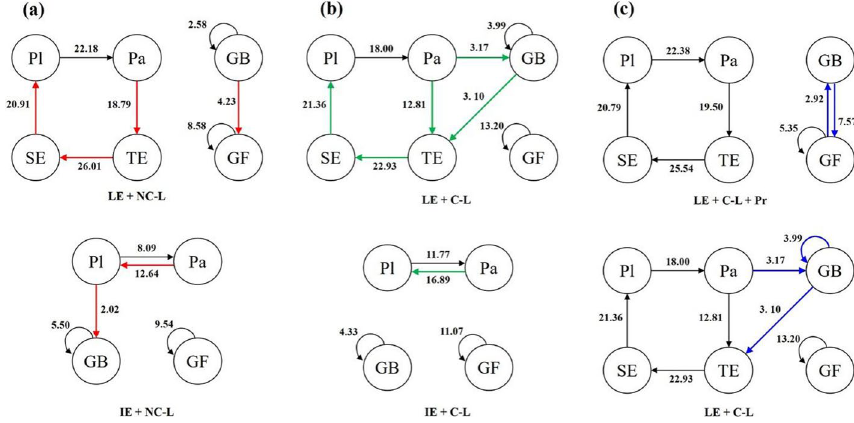
Fig. 5 Three comparisons of the behavior sequences: ( a ) LE C-L, and ( c ) LE explanation;